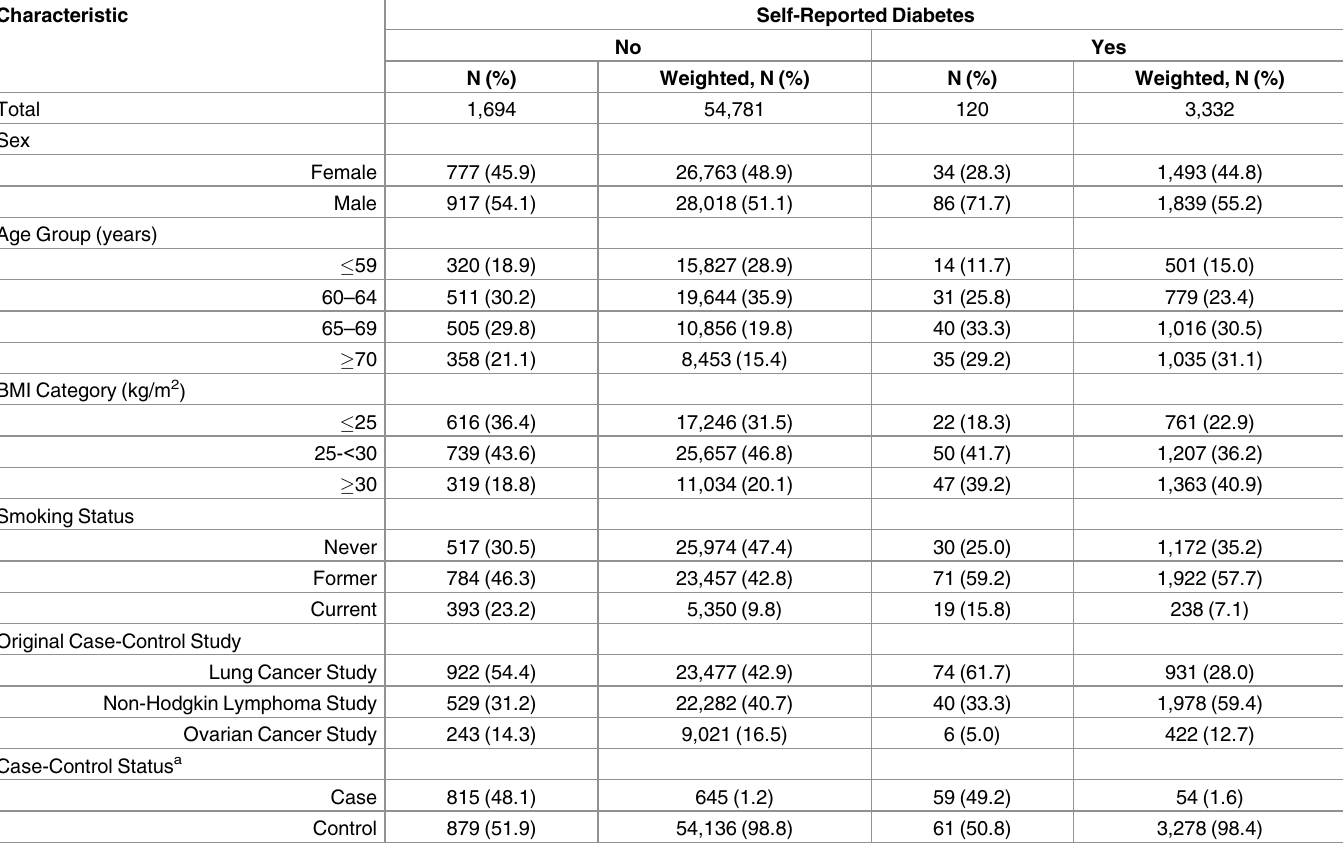
Table 1. Participant characteristics for the 1,819 individuals with inflammatory markerdata and the weighted population, by self-reported diabetes. Characteristic Self-Reported